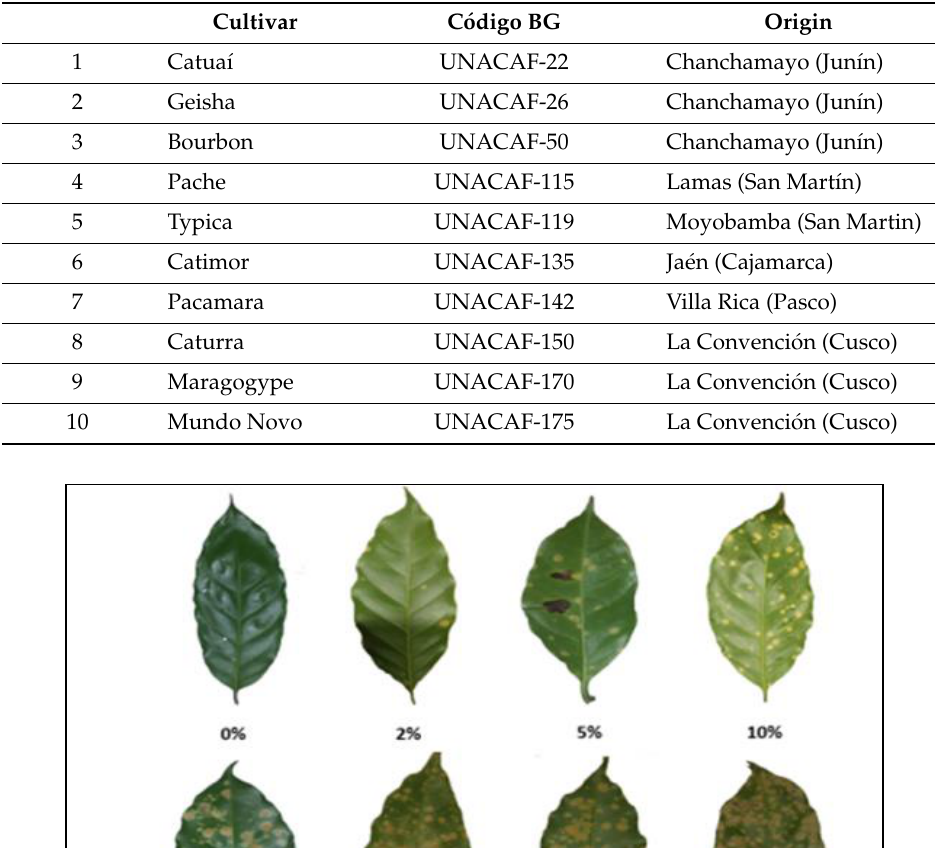
Table 1. Co ff ee cultivars studied in this evaluation and collection site in Peru [9].